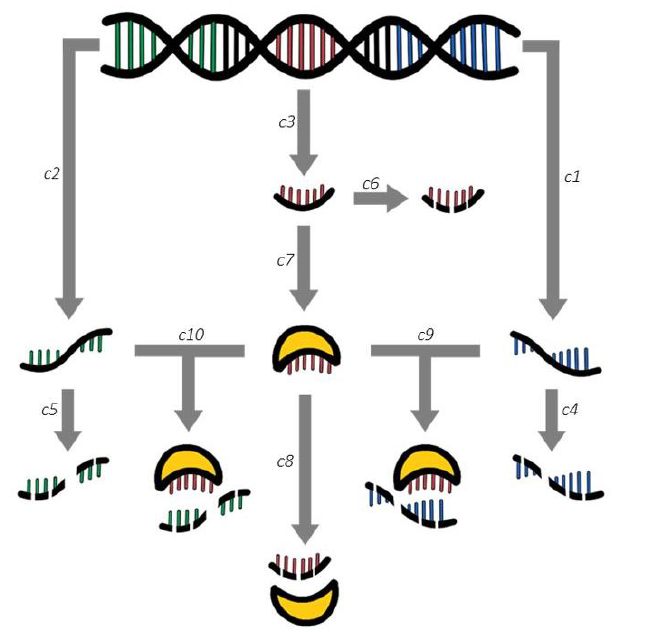
Figure 1. Proposed model of the miRNA regulatory network for